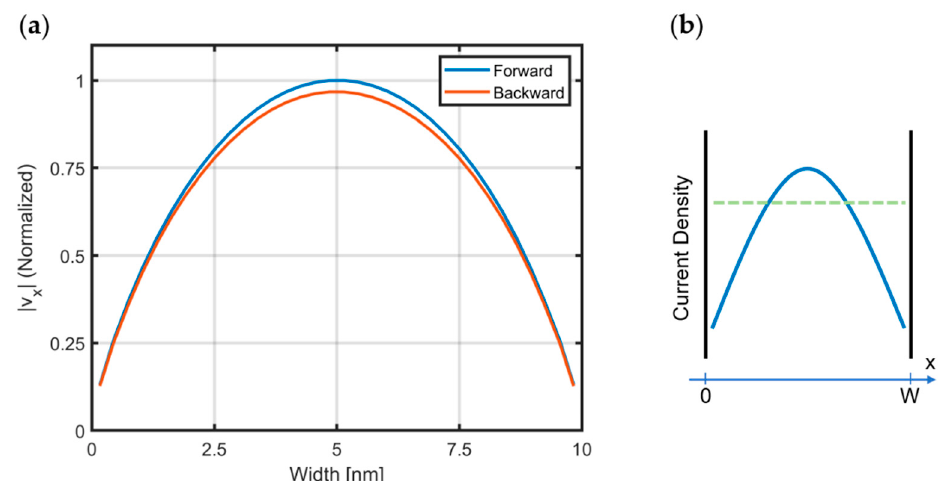
Figure 5. Velocity profile of electrons: ( a ) computed on the straight part of the Tesla valve geometry in Figure 2 near the right contact “b”. The electrons demonstrate Poiseuille flow as their velocity is maximum in the middle of the narrow channel and approach to zero near isolation-boundary condition of HDM. Moreover, the ‘easy’ flow direction predicts higher current values, as expected. ( b ) A schematic showing local-current-density profiles in a narrow channel (of width W) for conventional ohmic transport (green) and viscous Poiseuille flow (blue).